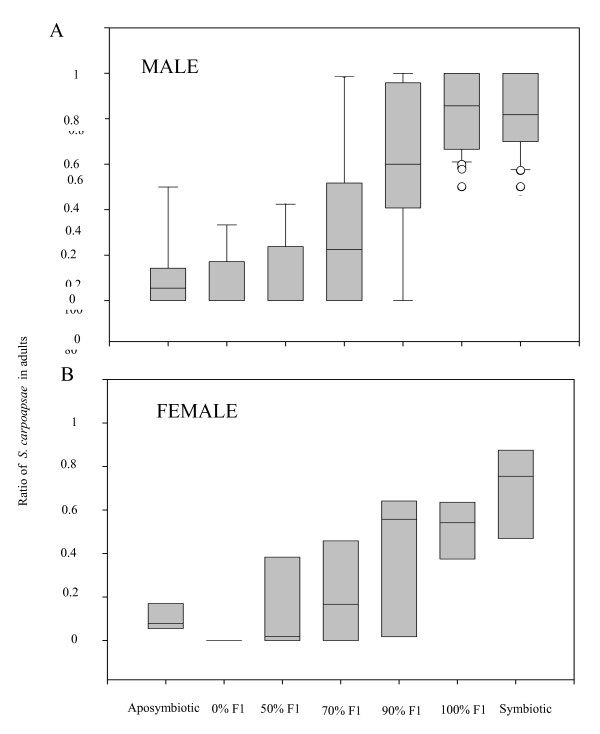
Percentile distribution of the ratio of S. carpocapsae within the total number of (A) nematode males and (B) nematode females found in the insect 120 h post-infection. Results are given as box plots, where the horizontal line indicate the median (50th of the data), the bottom and the top of the box indicate the first quartiles (25th of the data) and the third quartiles (75th of the data). The whiskers the range of the data (10th of the data and 90th of the data). Others dots are outliers which are under the 10th percentile of the data or over 90th percentile of the data. The abscissa shows the condition of the initial infection.